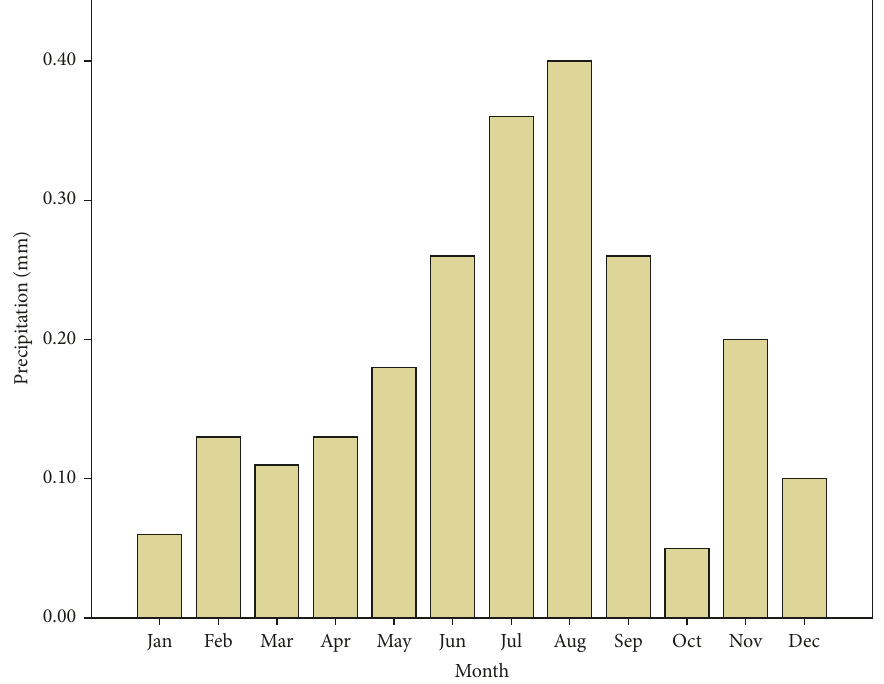
Figure 9: Monthly precipitation water during 30 years (1981 ∼